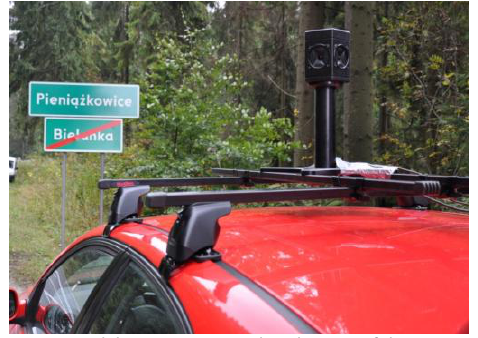
Figure 11 Ladybug®3 mounted at the top of the car in the district of Czarny Dunajec.